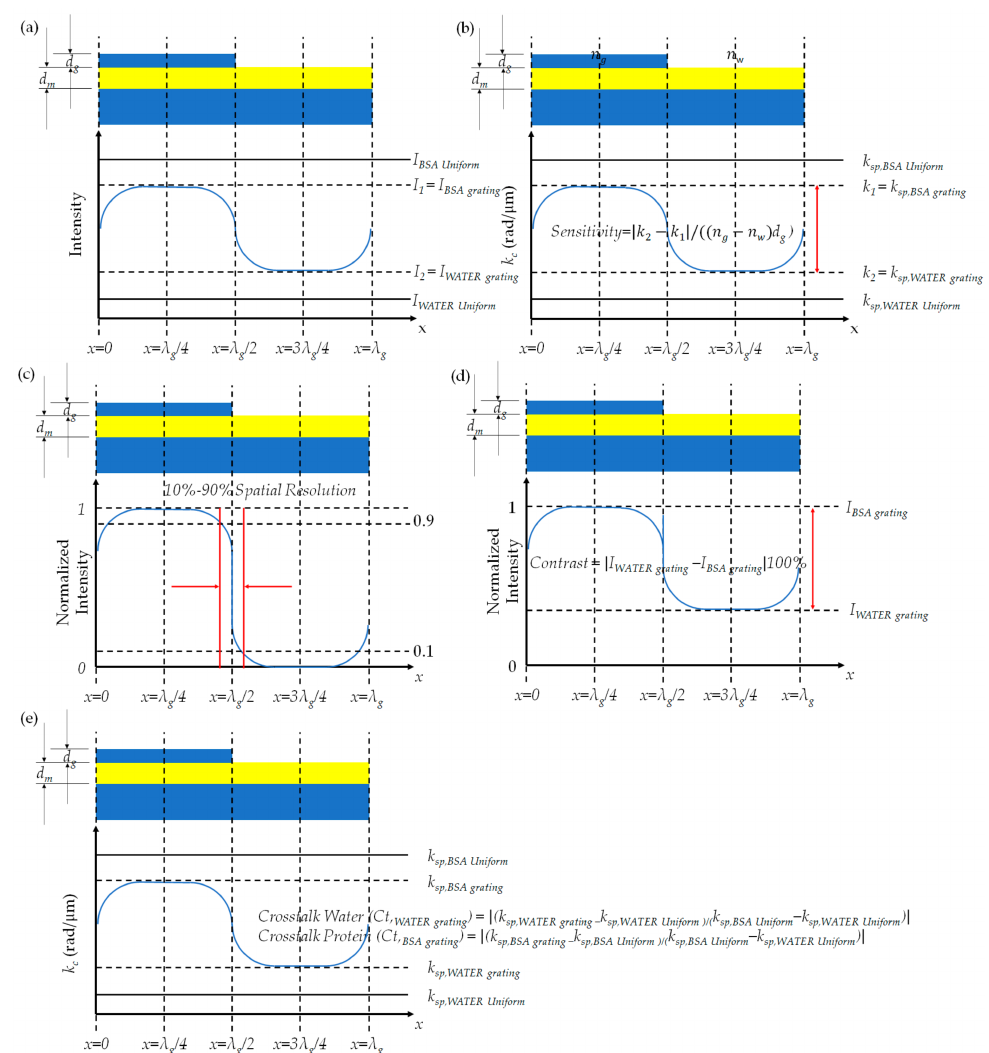
Figure 8. Shows the comparative performance parameters calculation details of the ( a ) intensity image from non-quantitative imaging, ( b ) recovered plasmonic angle for quantitative imaging and sensitivity calculation, ( c ) contrast calculation, ( d ) image normalization and 10–90% spatial resolution calculation, and ( e ) crosstalk